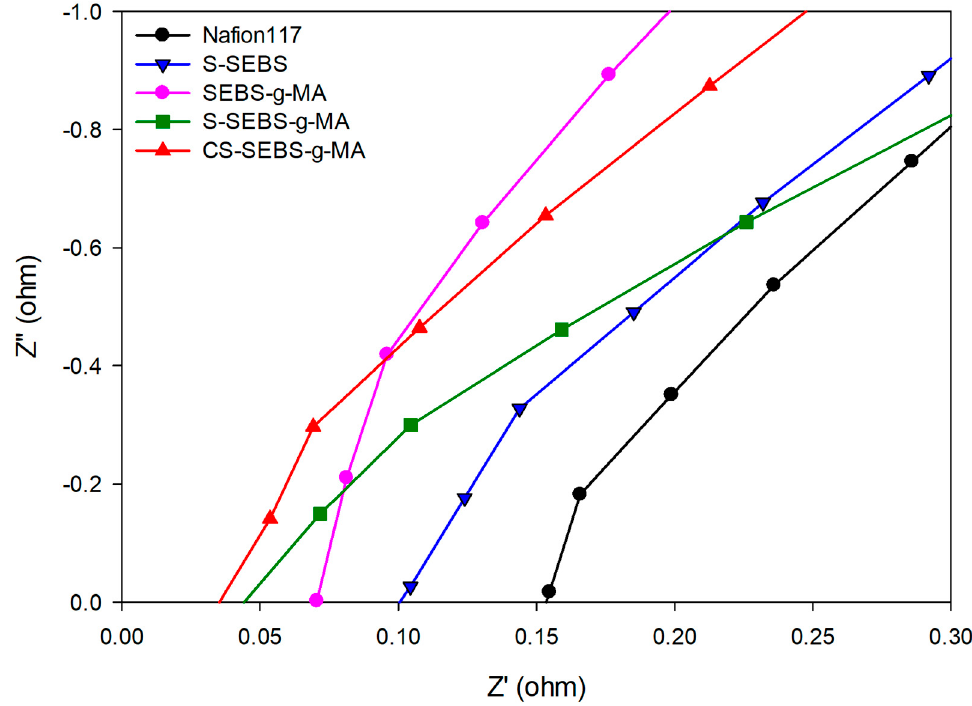
Figure 5. Impedance spectra of the Nafion 117, S-SEBS, SEBS-g-MA, S-SEBS-g-MA, and cross-linked S-SEBS-g-MA mem- branes. (Impedance data recorded at least for five sample from each set.).